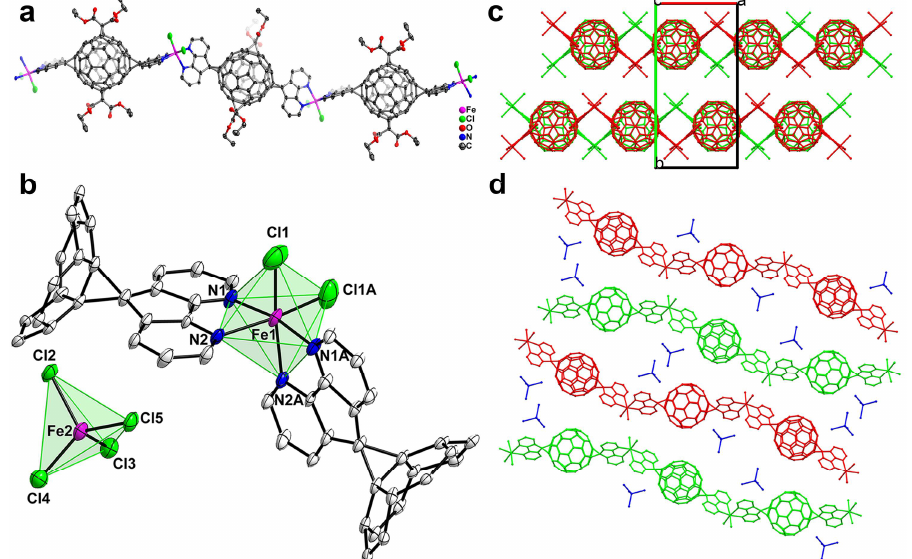
Figure 7. ( a ) 1D polymer chain structure in 6 . Front and back malonate addends and all hydrogen atoms were omitted for clarity; ( b ) coordination environments of Fe(III) cations; ( c ) the details of packing structure viewed down the c -axis; ( d ) ABAB-type alignment of individual chains; all the hydrogen atoms and malonate addends have been omitted for clarity.